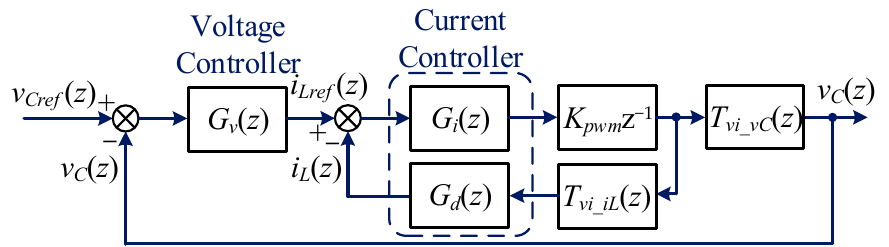
Figure 5. Simplified control block diagram of the proposed buck–boost inverter. Based on Figure 5 and the system parameter values listed in Table 1, the pole-zero map of the closed-loop voltage control is illustrated in Figure 6, where the zeros are represented as circles while the poles are denoted as crosses. The effectiveness of the proposed damping control block G d ( z ) can be clearly observed by comparing Figure 6a,b. As seen, the system poles are located much closer to the center of the unit circle after the carefully designed G d ( z ) is enabled. It should be highlighted that the variation in the duty cycle will influence the stability of the proposed inverter, while the stability of conventional H-bridge inverters is independent of d o . As a consequence, all the closed-loop poles should always stay within value of the output voltage v c should be given first, and then the maximum d o can be derived according to (8). Next, the variation range of d o can be obtained. Finally, the map of